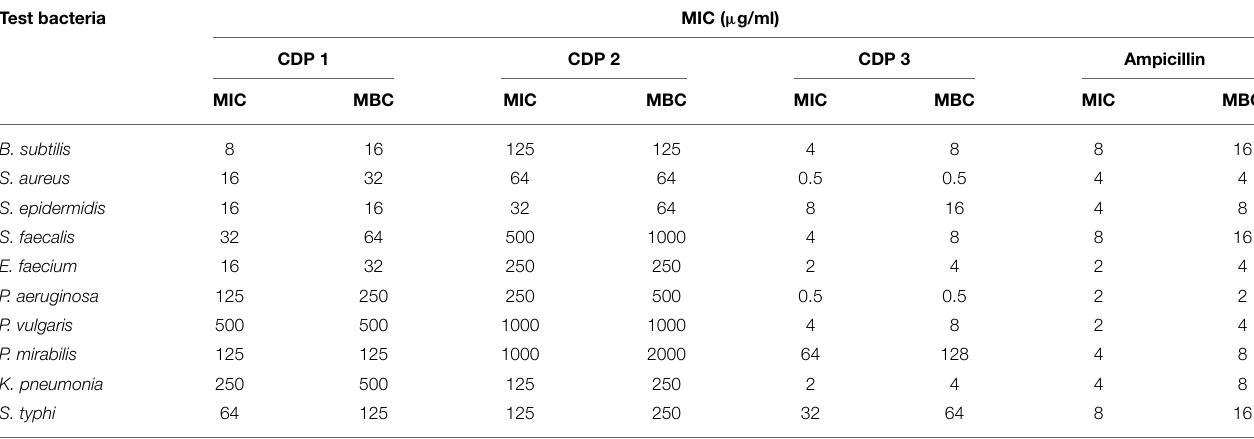
TABLE 2 | MIC and MBC of cyclic dipeptides against wound associated bacterial pathogens. Test